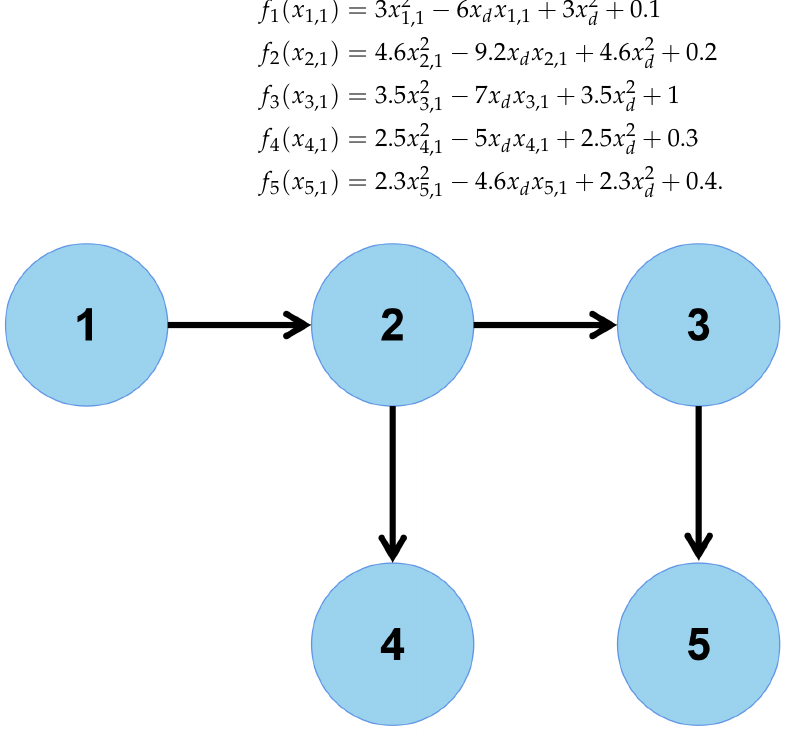
Figure 1. Communication